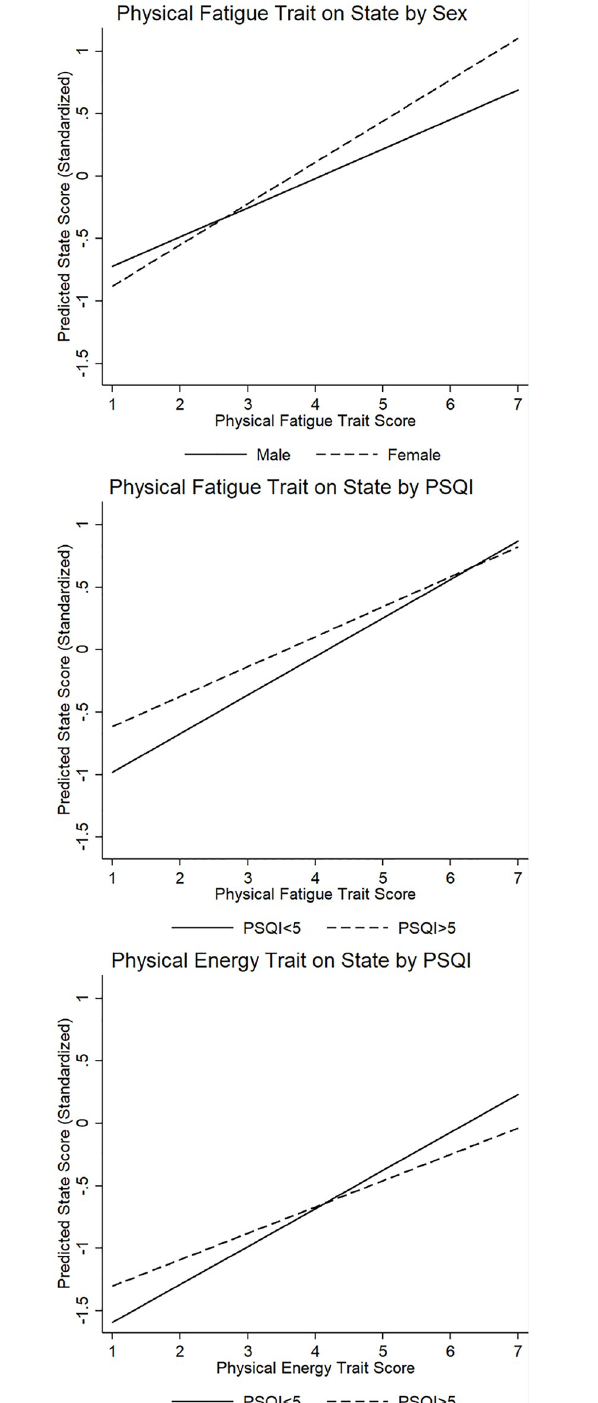
Fig 1. Interactions between trait variables and PSQI or sex in overall models.